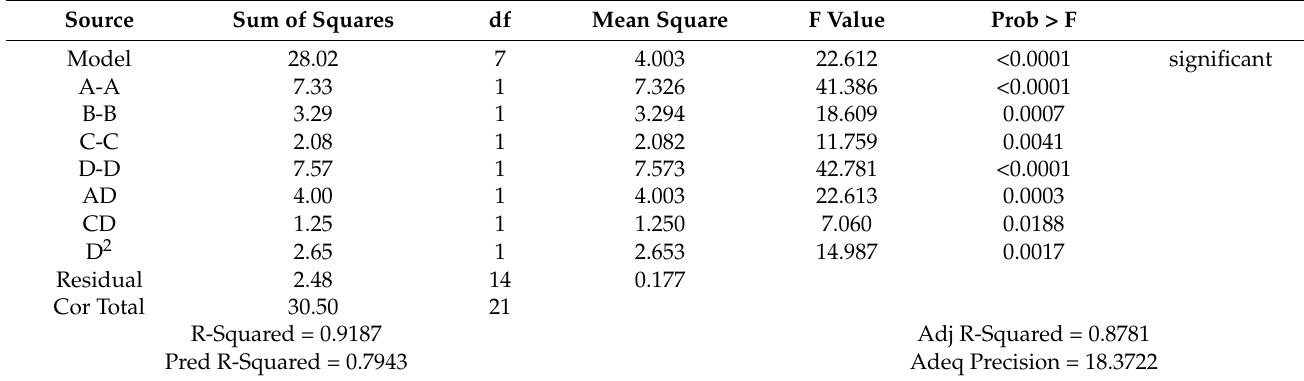
Table A5. ANOVA analysis for the regression model of weld